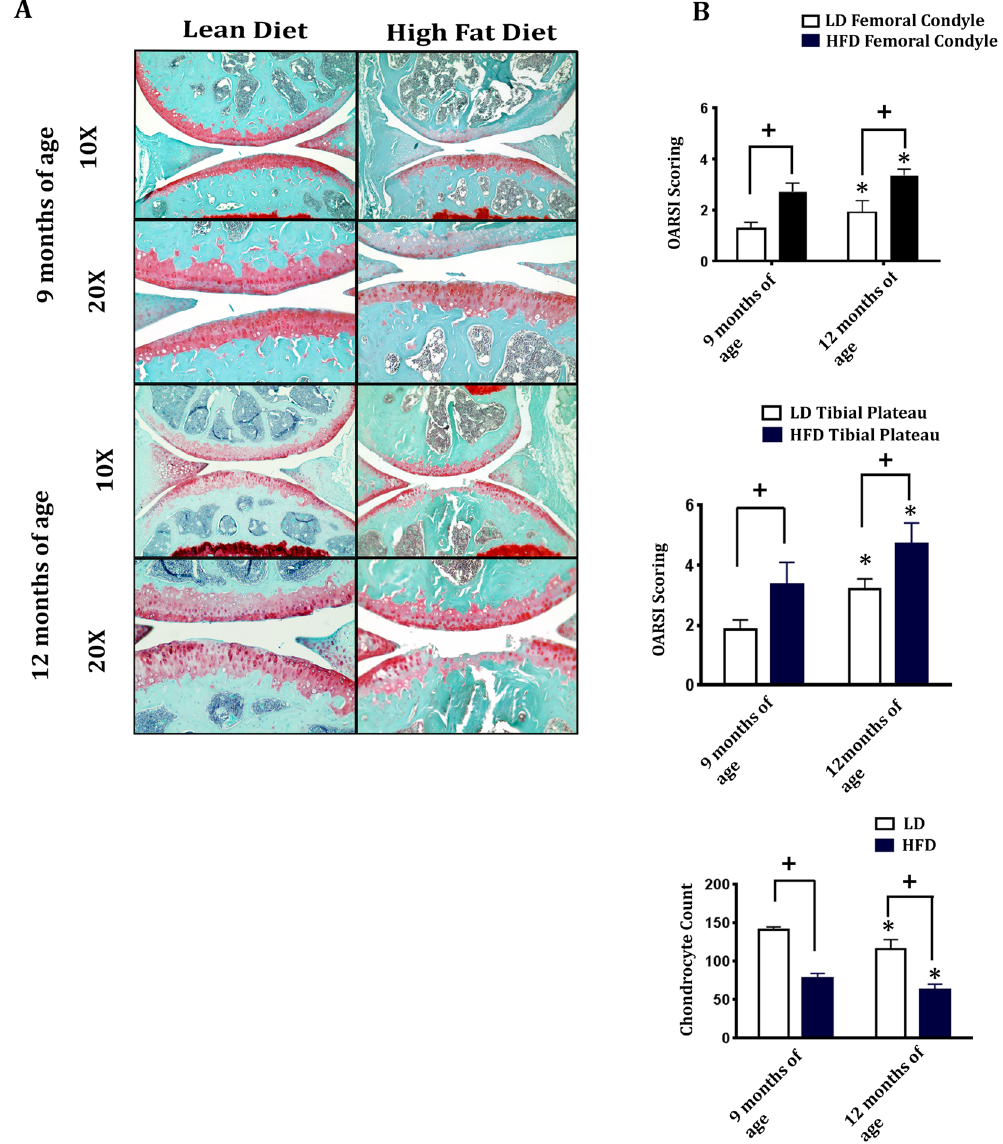
Figure 3. High fat diet-fed mice exhibit accelerated spontaneous OA. ( A ) Representative histological sections of Safranin-O/Fast Green stained knee joints from lean diet (LD) and high fat diet (HFD)-fed mice at 9 months and 12 months of age. Magnifications: 10x and 20x. ( B ) Severity of OA pathogenesis was determined by OARSI histopathology grading of mouse femoral condyles and tibial plateaus and number of chondrocytes per area were counted. Data are expressed as mean ± SD. Data were analysed by Two-way ANOVA followed by Holm- Sidak multiple comparison tests. * / + p < 0.05; n = 10. + p < 0.05 LD vs HFD at 9 months of age LD vs HFD at 12 months of age. * p < 0.05 HFD at 9 months of age vs HFD at 12 months of age and LD at 9 months of age vs LD at 12 months of age (n =